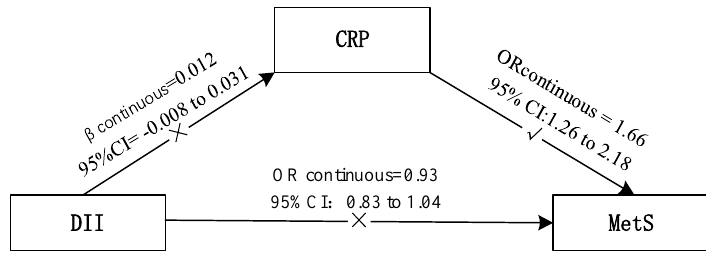
Figure 1. Association between DII, CRP and MetS. DII: dietary inflammatory index, CRP: C-reactive protein, MetS: metabolic syndrome.